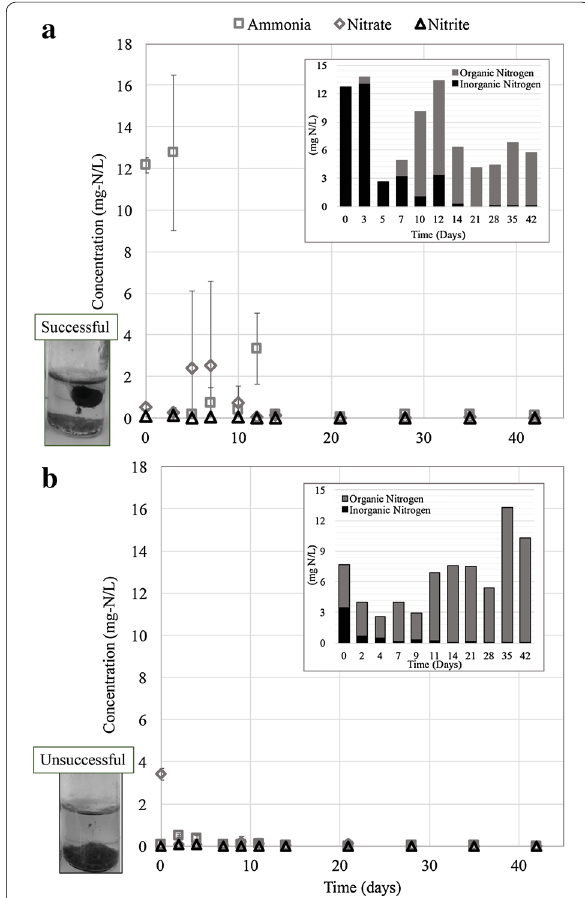
Fig. 3 Inorganic nitrogen species for a the successful cultivation and b the unsuccessful cultivation. The inset figure includes the total nitrogen for each sampling point and relative composition of organic and inorganic